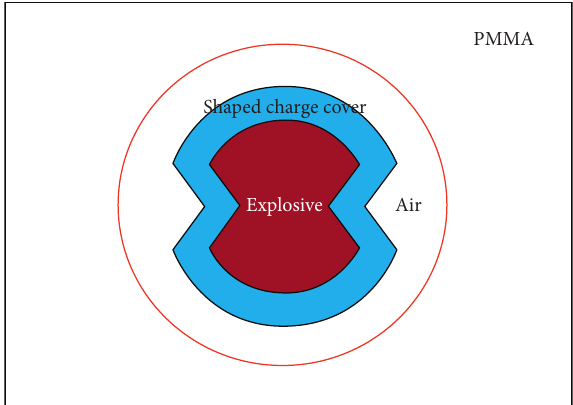
Figure 3: PMMA-shaped charge blasting